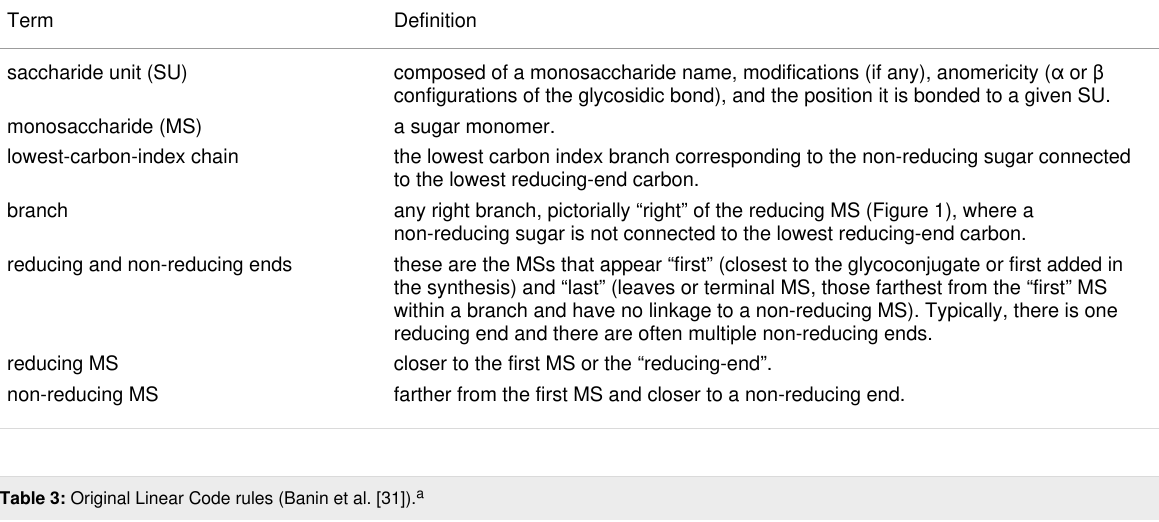
Rule description